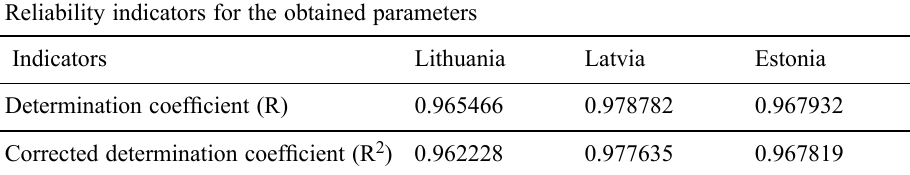
Table 7. Reliability indicators for the parameters obtained by multiple regression models for the size of deposits in the Baltic States and macroeconomic factors Reliability indicators for the obtained parameters Indicators Lithuania